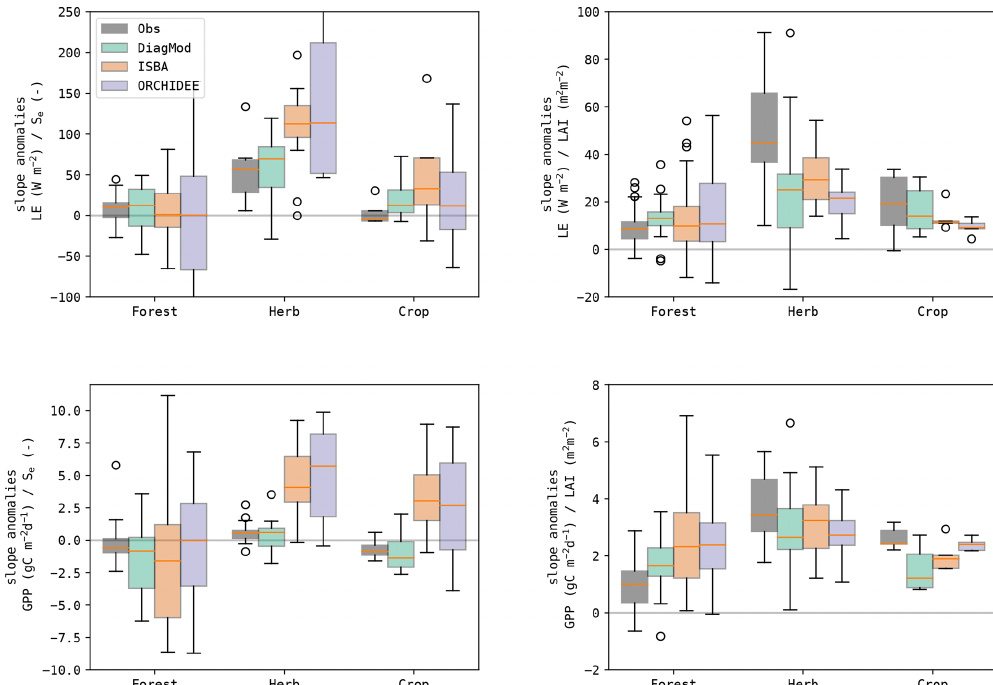
Figure 11. Boxplots of the slope of the linear regression between the anomalies in the state variables ( S e and LAI) and the fluxes ( LE and GPP) at the test sites, grouped per dominant land